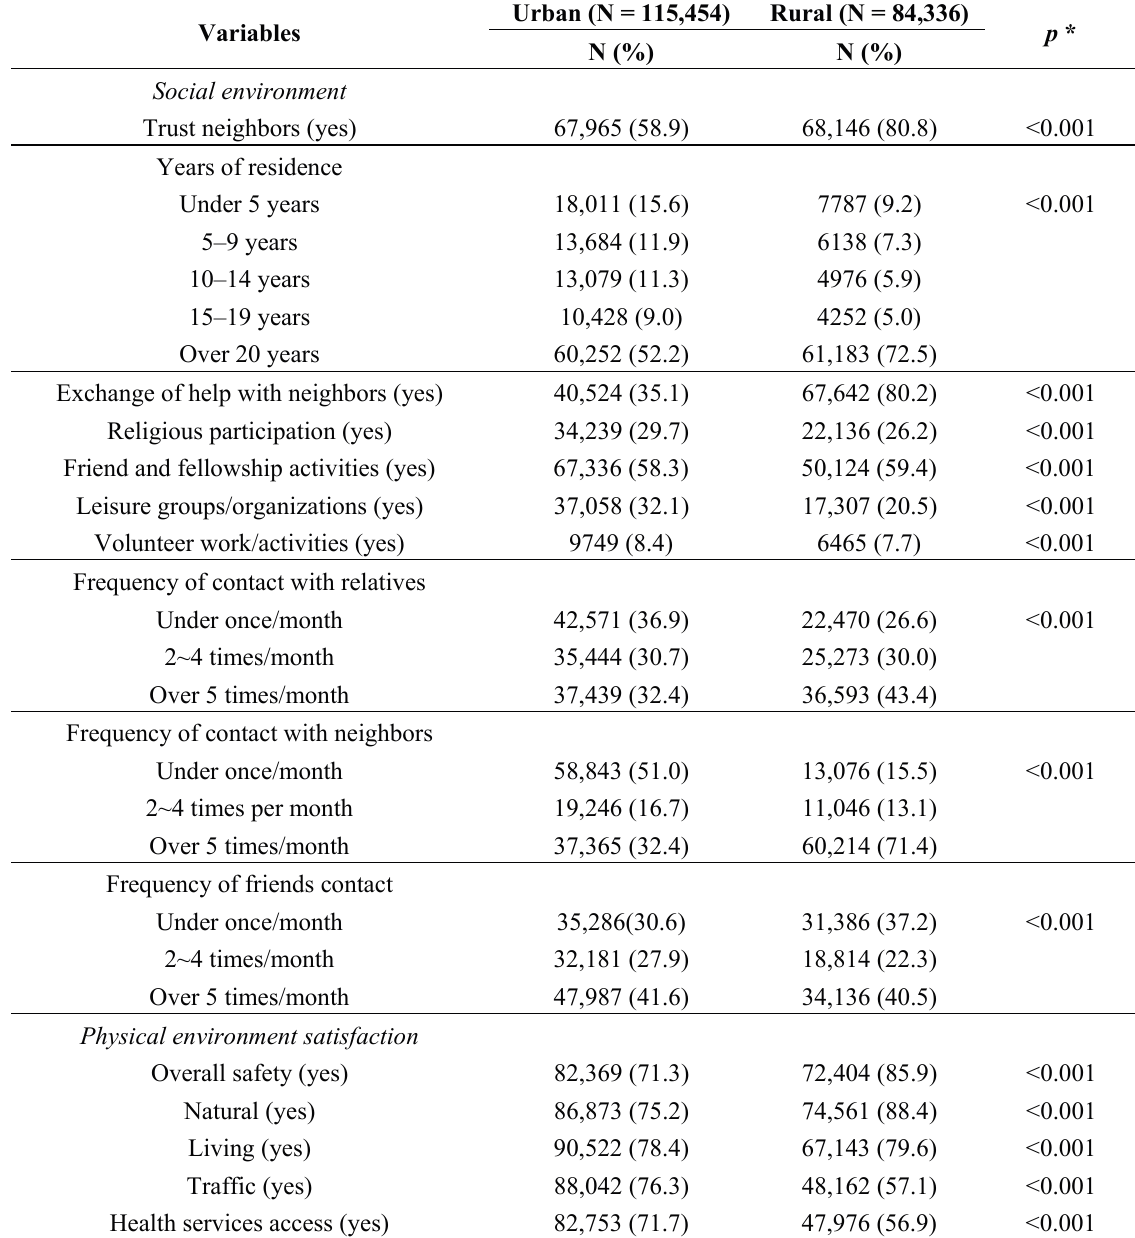
Table 2. Social and physical environmental factors according to